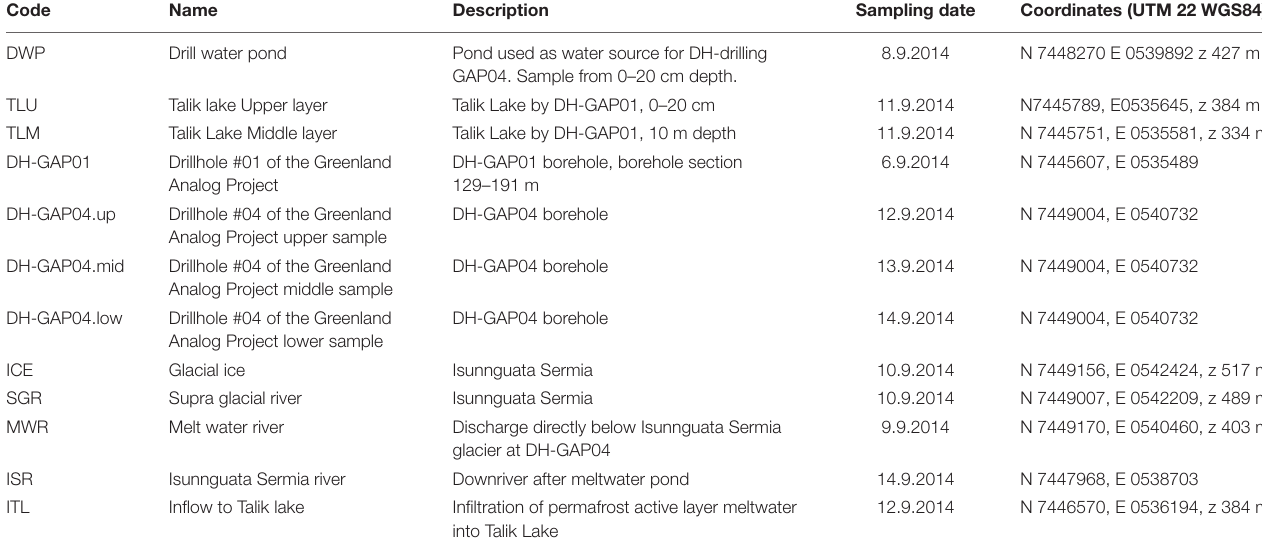
TABLE 1 | Sampling sites, dates and coordinates of the study and explanations to the abbreviations (Code) in Figure 1